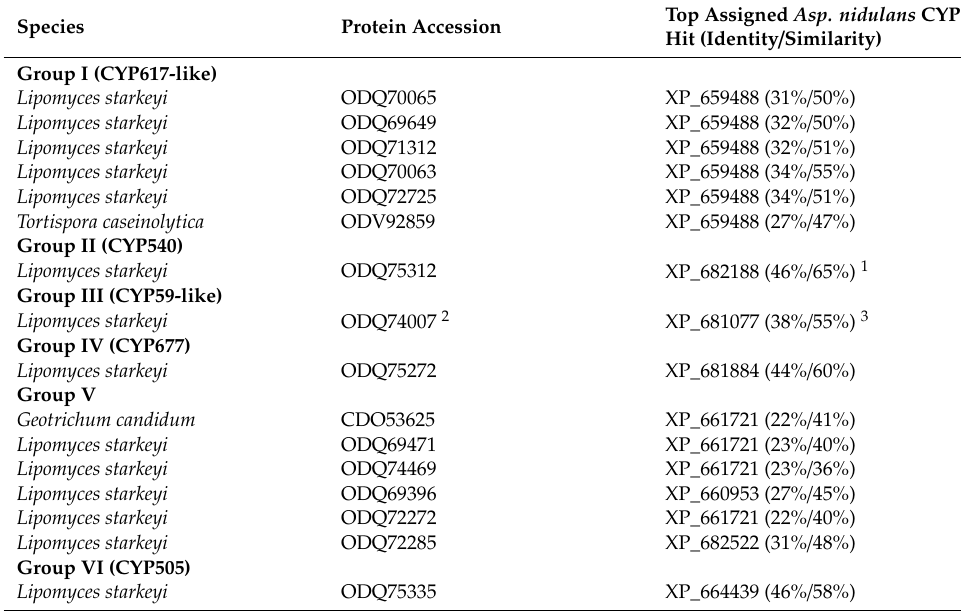
Table 2. CYP genes in basal budding yeast